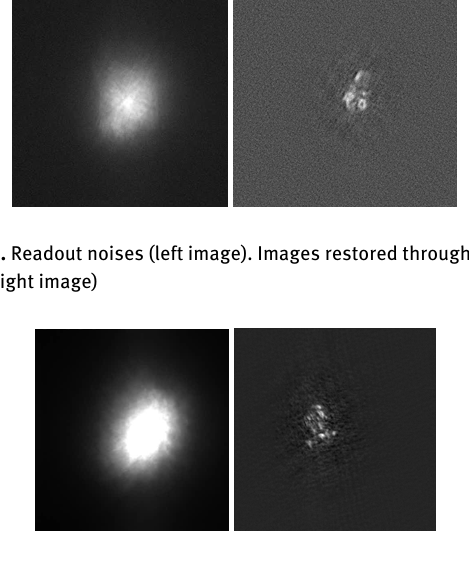
Figure 14. Non-linear effects (left image) and images restored through 70 accumulation frames (right image)